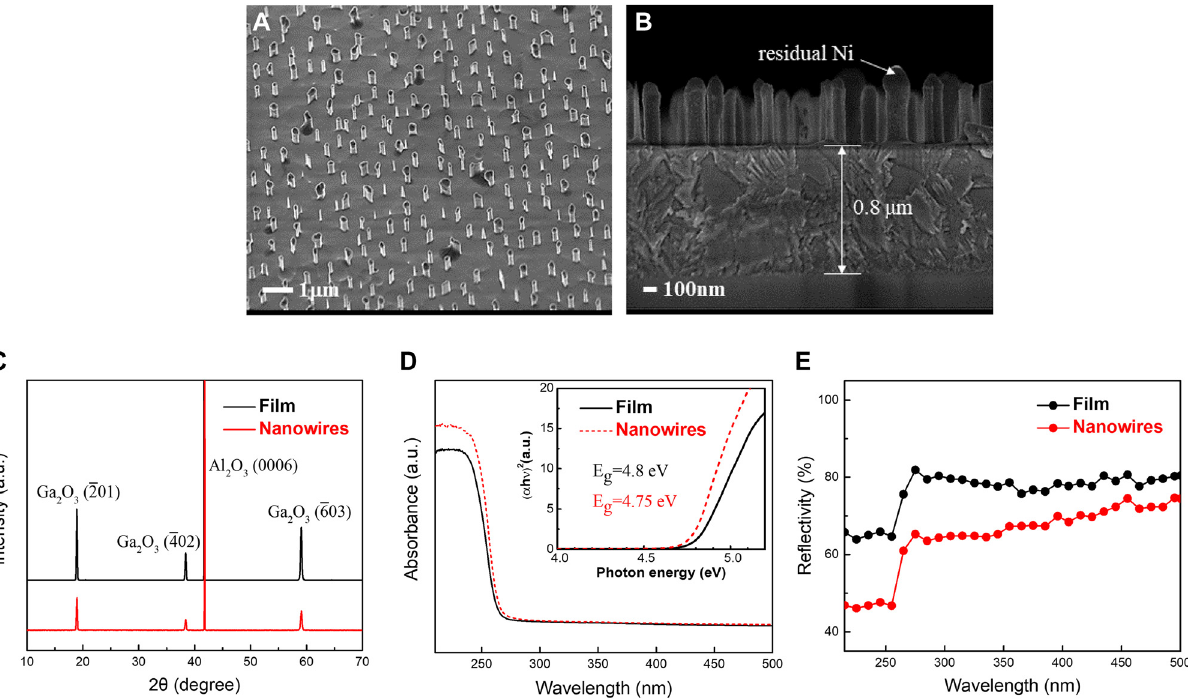
Figure 2: Morphology and characterization of β -Ga 2 O 3 nanowire arrays. (A, B) Tilted-view and cross-sectional scanning electron microscope (SEM) images of vertical β -Ga 2 O 3 nanowire arrays. (C – E) X-ray diffraction (XRD) patterns, optical absorbance and re fl ection spectra of β -Ga 2 O 3 nanowires and original fi lm. (Inset) ( α h ν ) 2 versus h ν